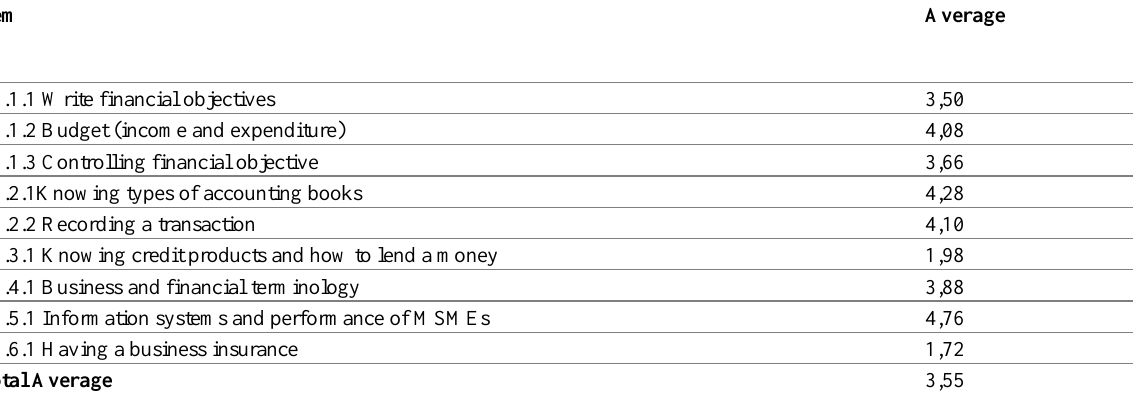
Table 2: Description Analysis of Financial Literacy (X1)